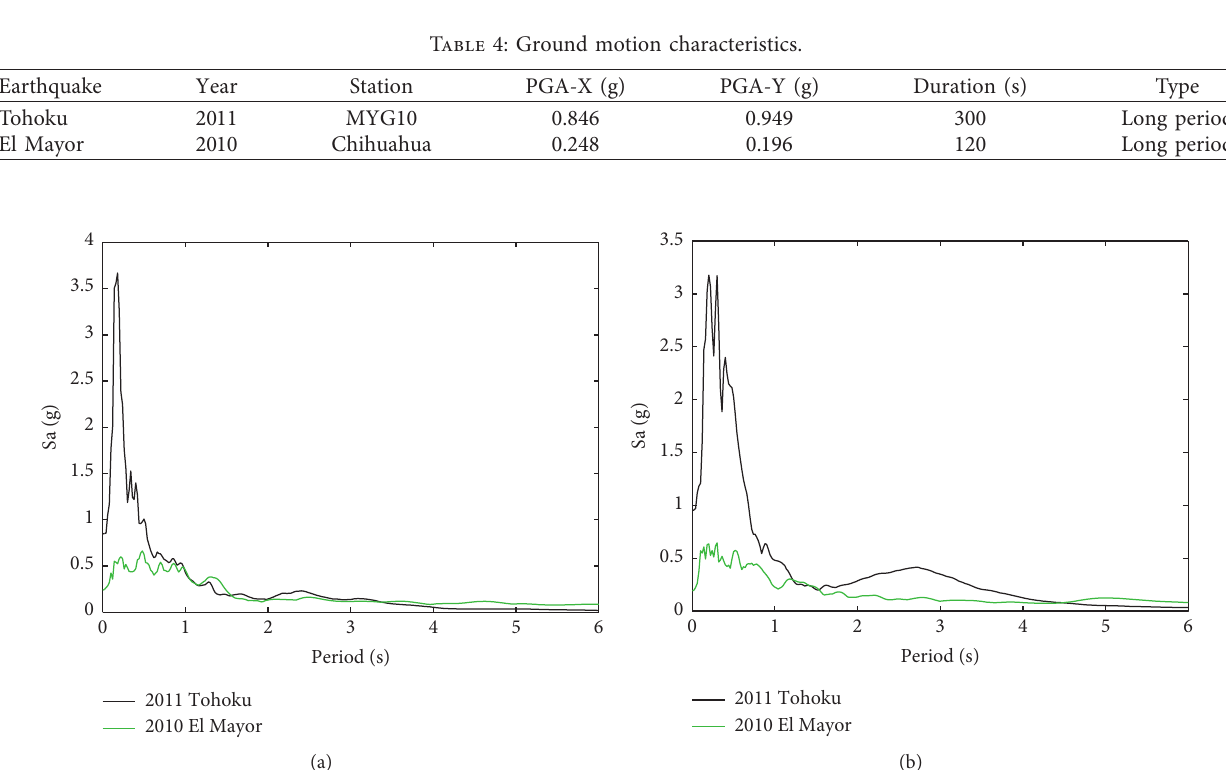
Figure 7: Spectral acceleration of selected ground motions applied in X (a) and Y (b) directions of the structure.